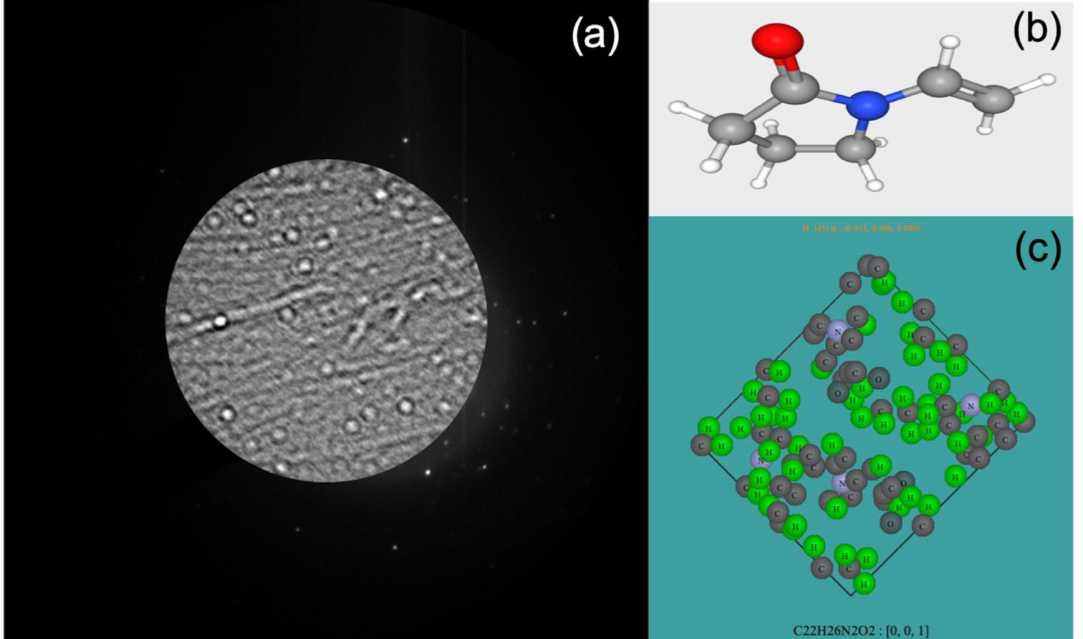
Figure 3. ( a ) in line-hologram on Vinpocetine and polyvinylpyrrolidone acquired in di ff raction mode. ( b ) 3D Chemical structure of polyvinylpyrrolidone (gray atoms: C; white atoms: H; red atoms: O; blue atoms: N). ( c ) Crystal cell of Vinpocetine in [0,0,1] zone